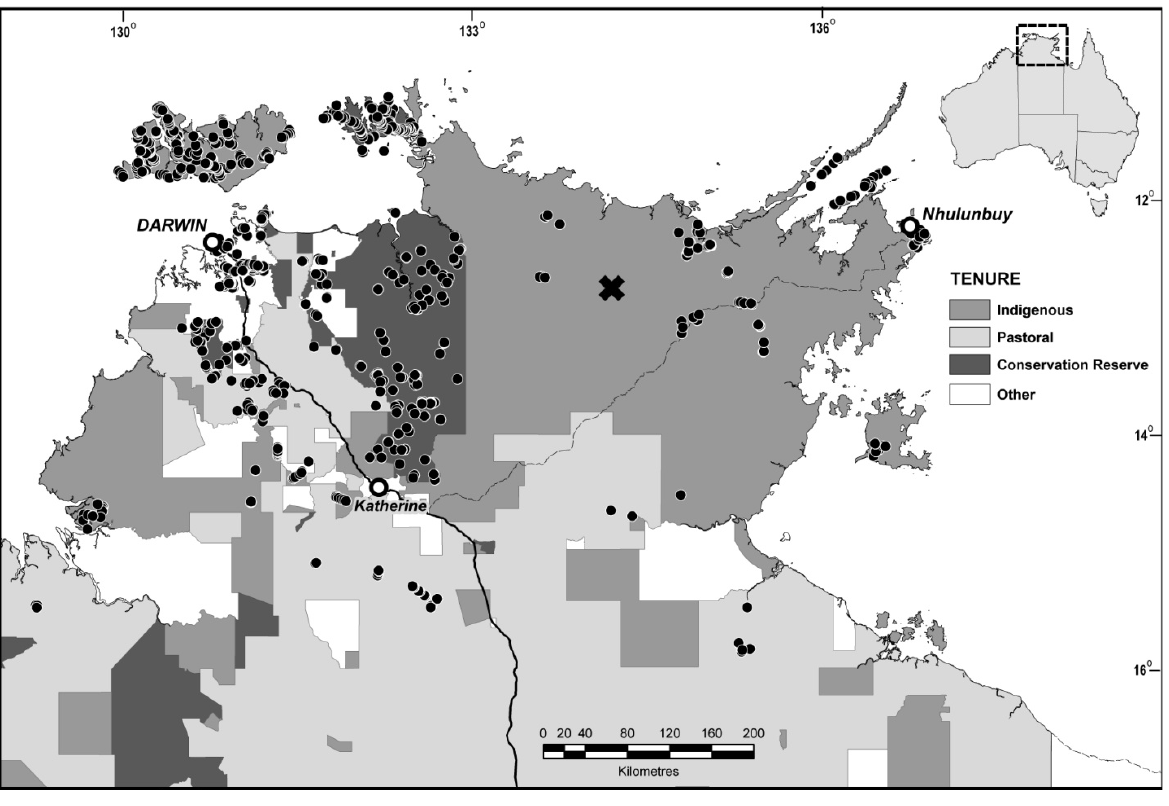
Figure 1. Location of study area, land tenure and sampled quadrats. The location of the Cadell River study of [9] is indicated with a